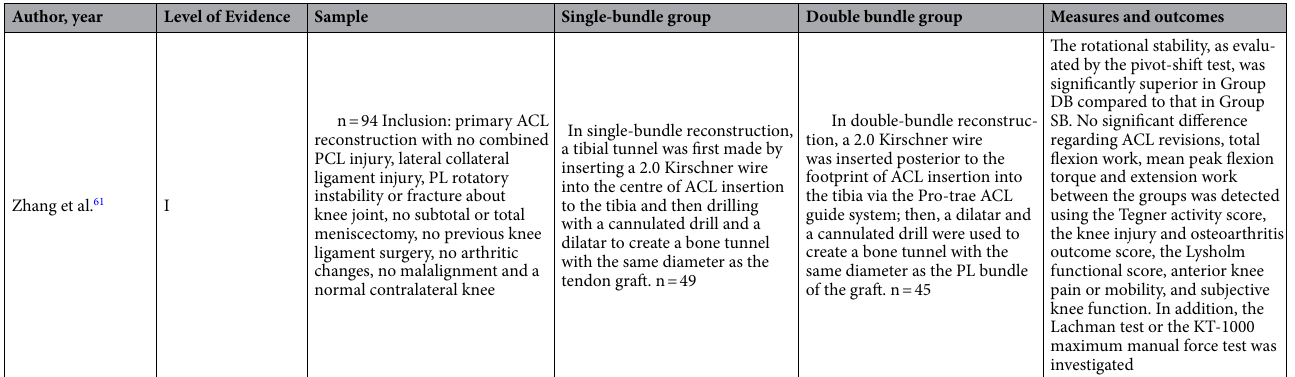
Table 1. Study characteristics. ACL anterior cruciate ligament, ACLR anterior cruciate ligament reconstruction, AM anteromedial, AMB anteromedial-bundle, BPTB bone-patellar tendon-bone, DB double- bundle, HG human givens, IKDC international Knee Documentation Committee, KOOS Knee injury, osteoarthritis and outcome score, LBPTB lateralized single-bundle bone-patellar tendon-bone, MCL medial collateral ligament, mm millimetres, NaDBH Non-anatomical autologous double-bundle, PCL posterior cruciate ligament, PL posterolateral, PLB posterolateral-bundle, ROM range of motion, SB single-bundle, VAS visual analogue scale.